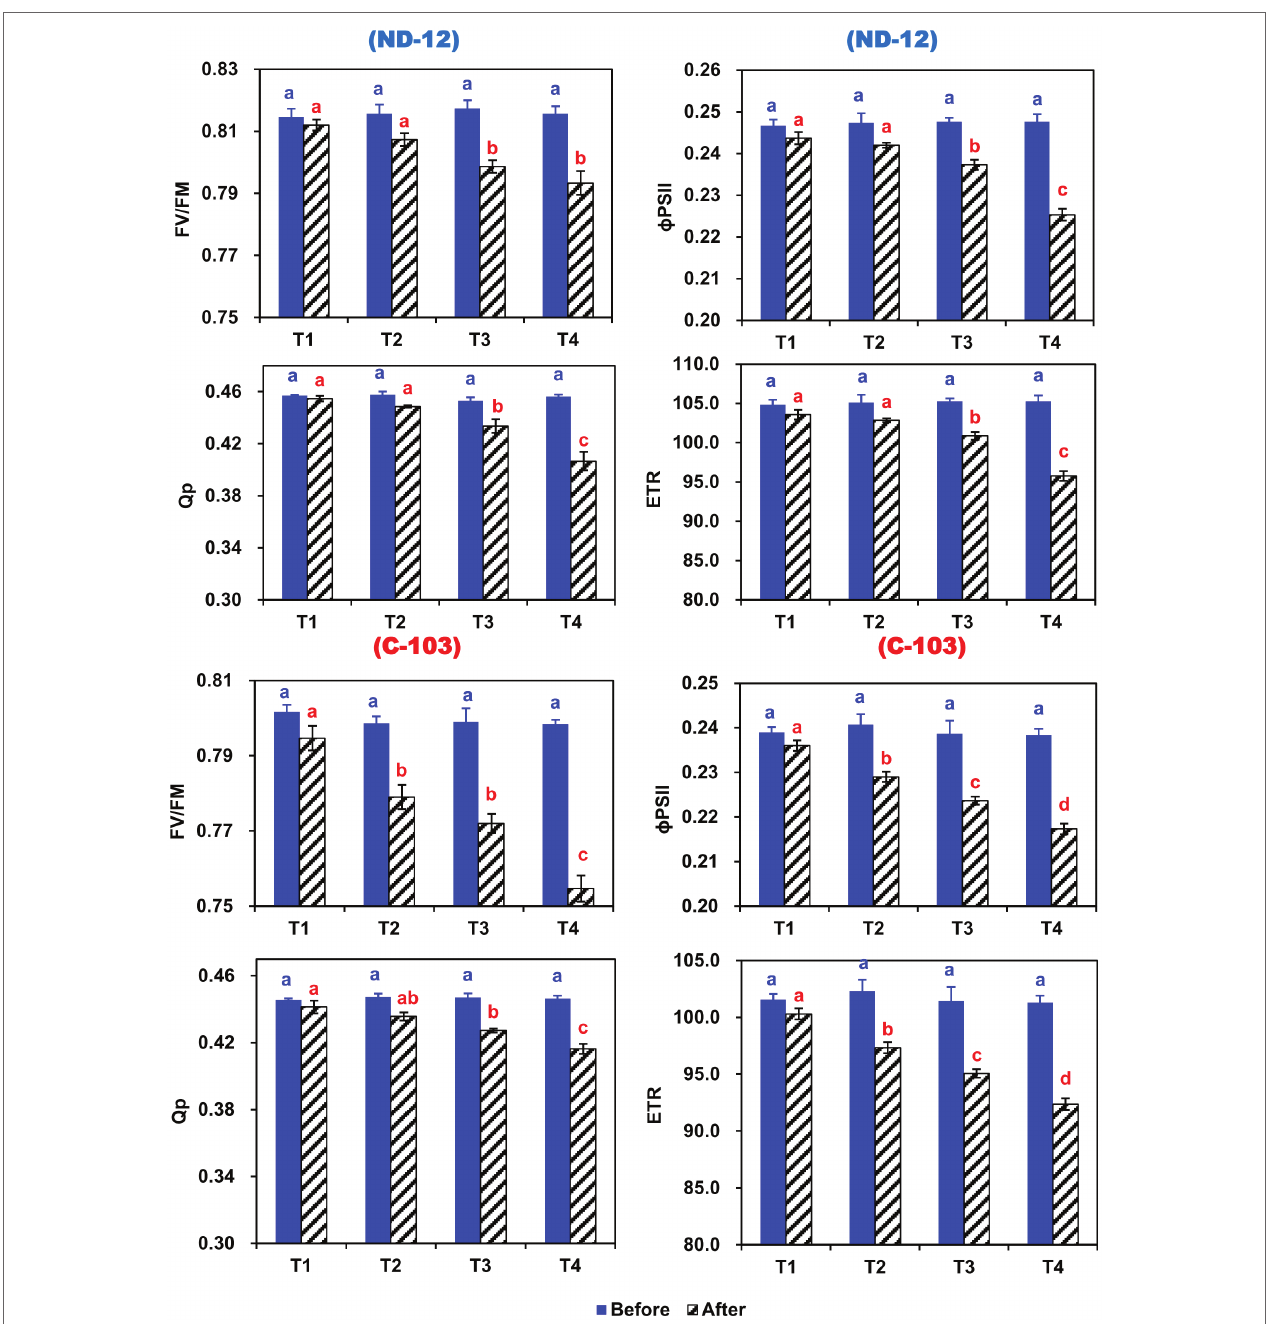
FIGURE 4 | Effect of different split-root PEG treatments on chlorophyll fluorescence parameters of two soybean cultivars ND-12 (drought-resistant) and C-103 (drought-susceptible). (Mean ± SE), same small letters are not significantly different at p < 0.05. T1 (0%: 0%), T2 (2%A: 0%B), T3 (6%A: 0%B), and T4 (4%A: 6%B). Maximum quantum yield (Fv/Fm), effective quantum yield of photosystem ( ɸ PSII), photochemical quenching (qP), and electron transport rate